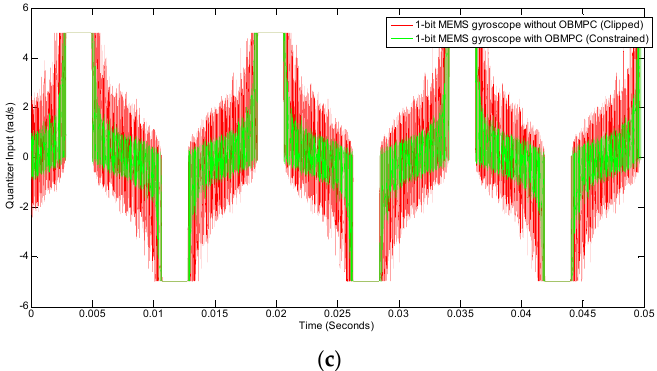
Figure 12. Results for the OBMPC-based MEMS gyroscope with Amplitude = 1.1 rad/s ( a ) MEMS gyroscope with sinusoidal input; ( b ) Spectra comparison; ( c ) Comparison of the quantizer input. To further discuss the character of the proposed MEMS gyroscope, the OBMPC-based MEMS is compared with its benchmark under different sampling frequencies. The SNR and the MSE of the quantization noise are plotted in Figure 13.